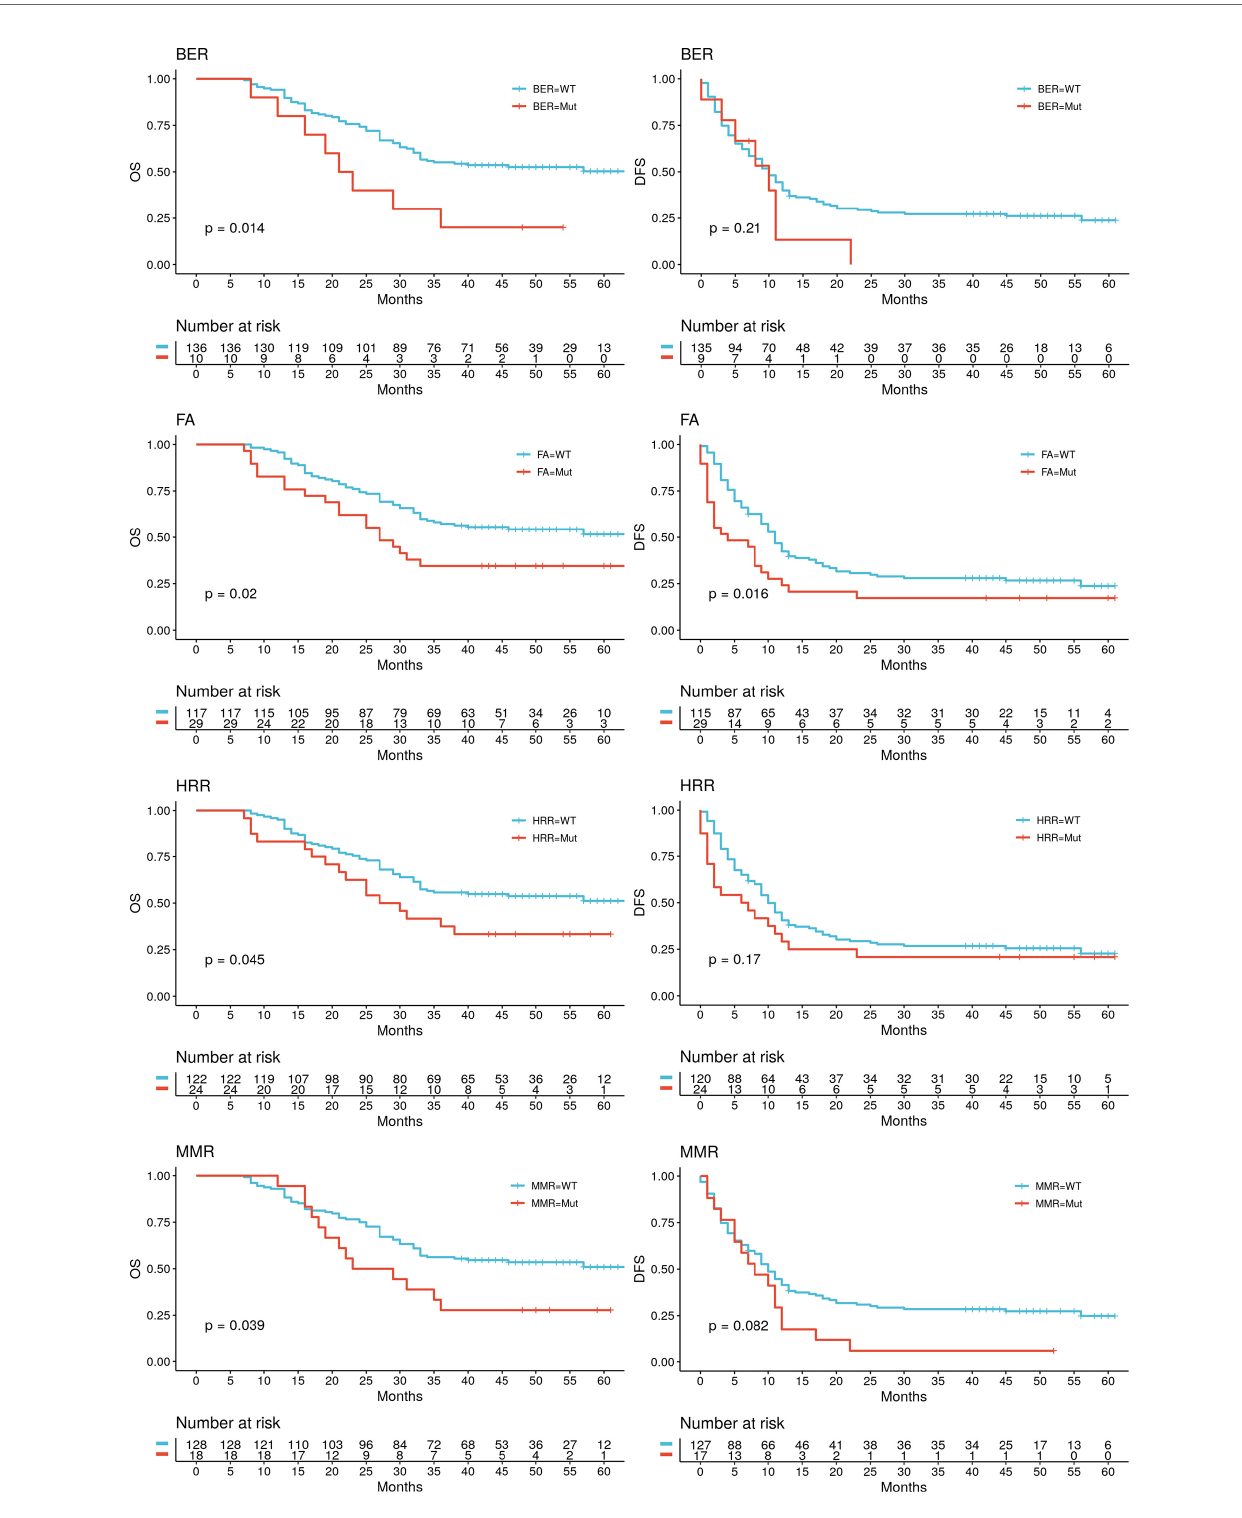
Frontiers in Oncology |